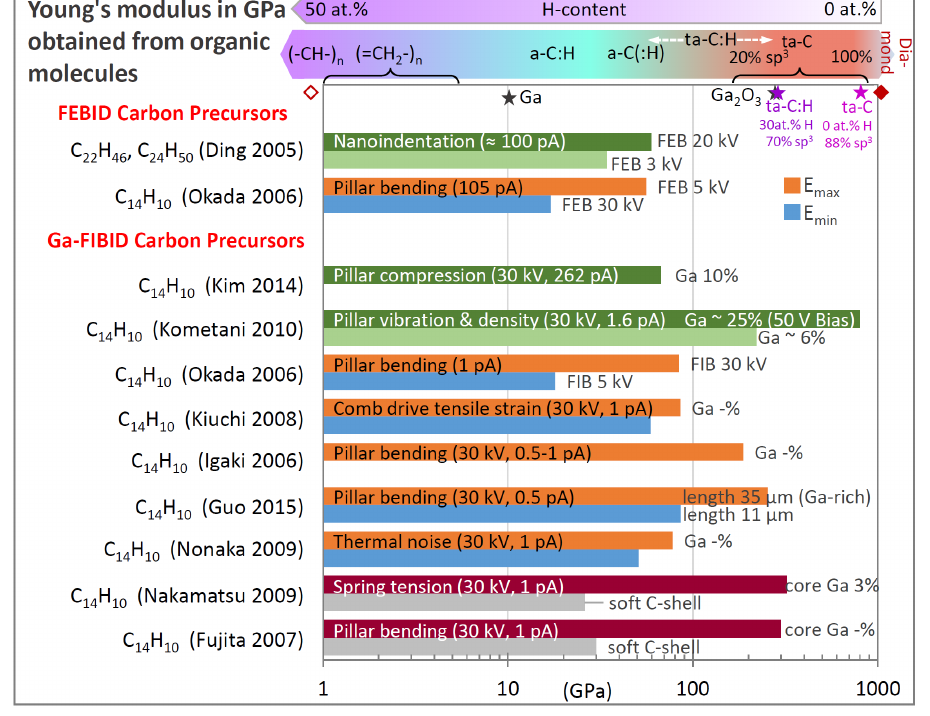
Figure 11. Summary of elastic moduli derived from as-grown FEBID and Ga-FIBID grown carbon materials; all using either paraffin (C 22 H 46 and C 48 H 50 ) or phenanthrene (C 14 H 10 ). The vertical axis lists the precursor molecule used to grow the structure and the author reference. The measurement, deposition parameters (acceleration voltage, beam current), and the Ga implantation contents in at.% (when reported) for FIB deposits are indicated. On the top values and ranges of elastic moduli for polymers, various carbon types, diamond ( 𝐸 = 1143 GPa), gallium, and gallium oxide are shown for orientation. The trend in hydrogen content is indicated. Maximum and minimum values have specific legends when parameter studies were performed; otherwise, they show the experimental scatter. Note the logarithmic horizontal scale. Green colored bars represent measurements on homogeneous material, red-gray colored bars represent core–shell structures, and blue-orange bars made no core– shell distinction.